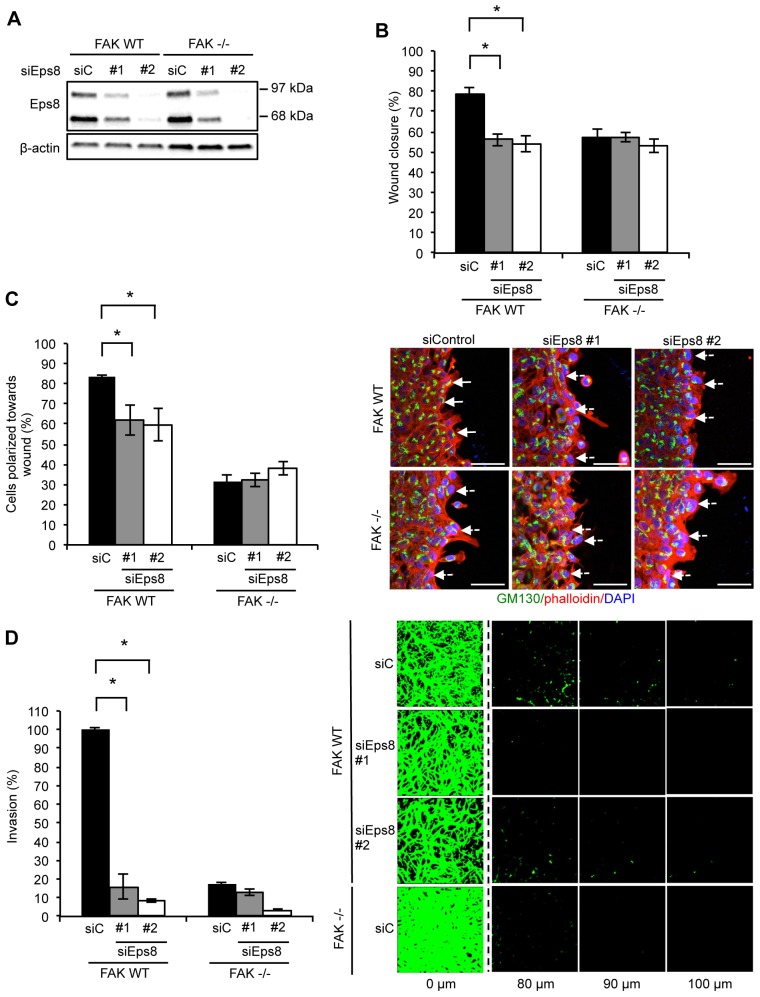
Eps8 regulates polarized cell migration and invasion. FAK WT and FAK−/− cells were transiently transfected with two independent Eps8 siRNAs (siEps8 #1 and #2; siC, control siRNA) and (A) lysed 48 h post transfection and Eps8 expression determined by western blotting using anti-Eps8 antibody. Anti-β-actin was used as a loading control. (B) Confluent monolayers of cells plated on fibronectin were wounded using a pipette tip. Wound closure was quantified at 15 h post wounding. Results are mean±s.e.m. *P<0.01 (Student's t-test). (C) Confluent monolayers of cells plated on fibronectin were wounded using a pipette tip, fixed 3 h later and stained with anti-GM130 antibody (to label the Golgi) and TRITC–phalloidin. Polarization was scored using the orientation of the Golgi towards the wound edge. Solid arrows indicate polarized cells. Dashed arrows indicate unpolarized cells. Scale bars: 20 µm. Results are mean±s.d. *P<0.001 (Student's t-test). (D) Cells were seeded on growth-factor-reduced Matrigel in serum-free conditions. Invasion towards a serum gradient (the distance of the horizontal z-section from the top of Matrigel is given) was visualized after 72 h by staining the cells with calcein. Results are mean±s.e.m. *P<0.001 (Student's t-test). Quantification is representative of at least three independent experiments in all cases.